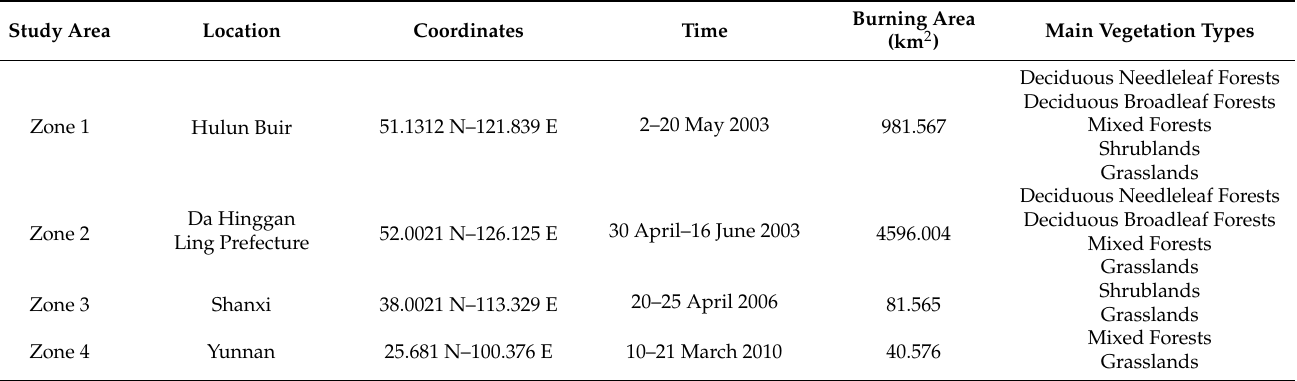
Table 1. Location, time, and burning area of fire points in China from 2003 to